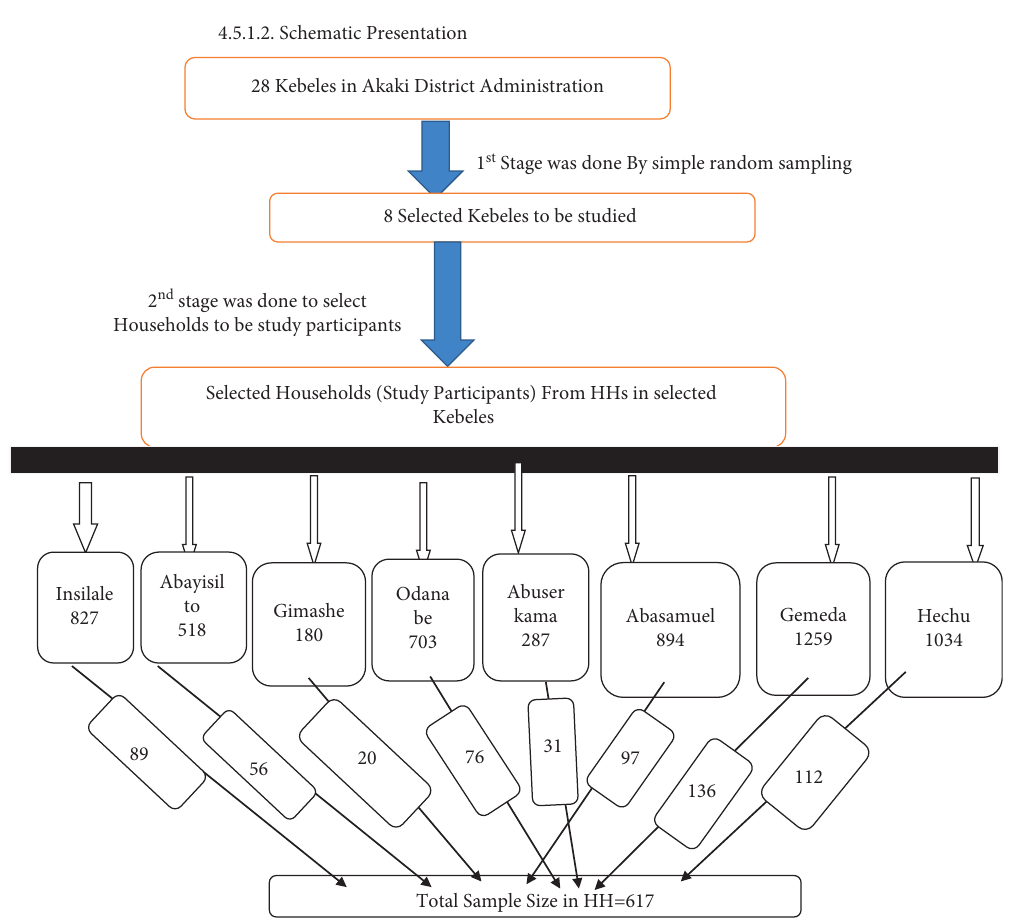
Figure 1: Sampling frame, the sample size calculated for CBHI utilization and its associated